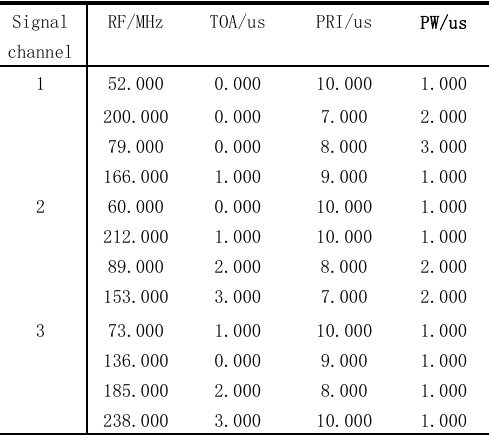
Table 1. Parameters of four channels’